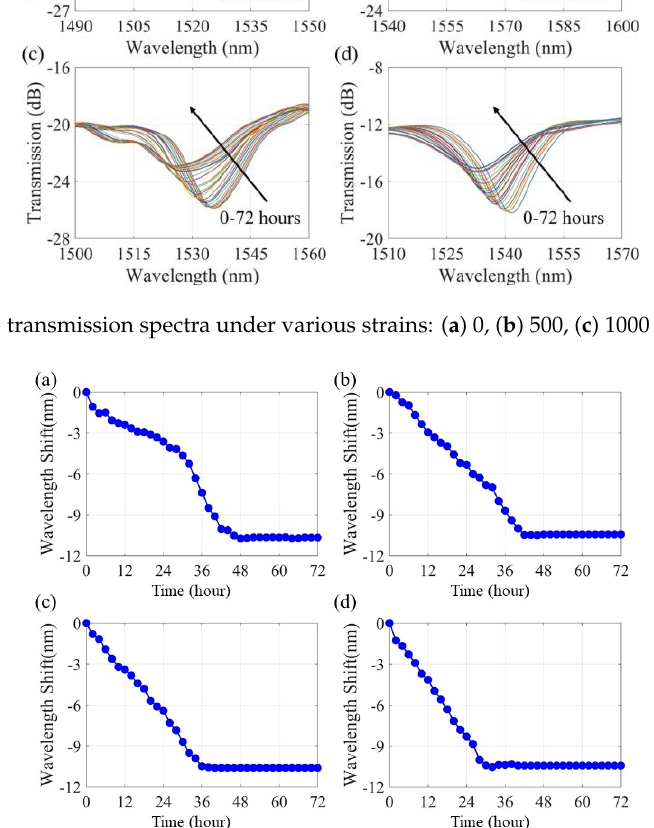
Figure 10. Resonant wavelength shift over time: ( a ) 0, ( b ) 500, ( c ) 1000 and ( d ) 1500 µε .